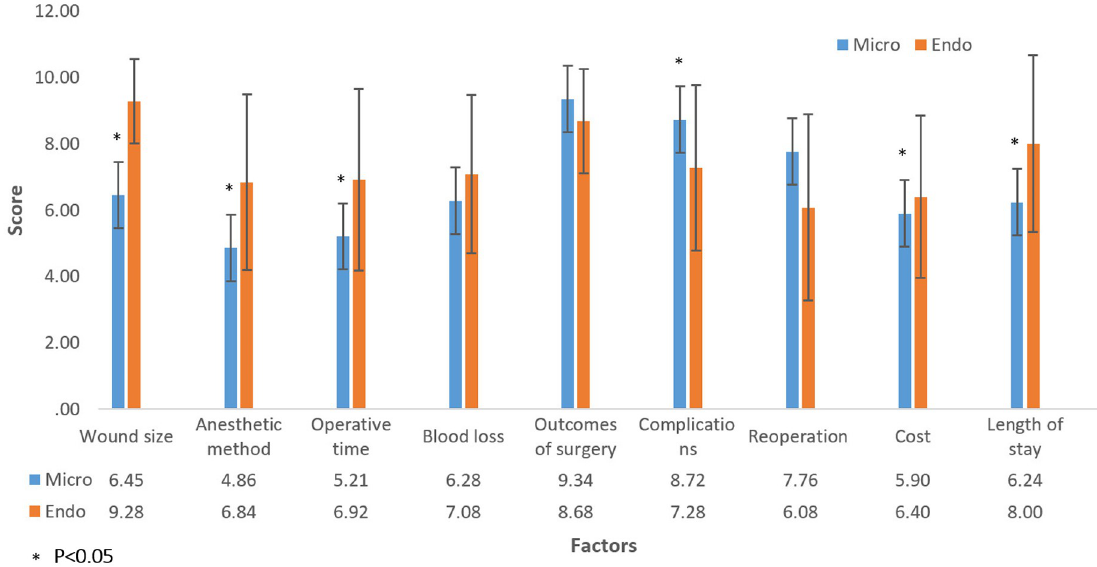
Fig 2. Opinions of the participants who had experience in lumbar discectomy for how important of these factors to select the microscopic lumbar discectomy or endoscopic lumbar discectomy [Scale from 1 (least important) to 10 (most important)].